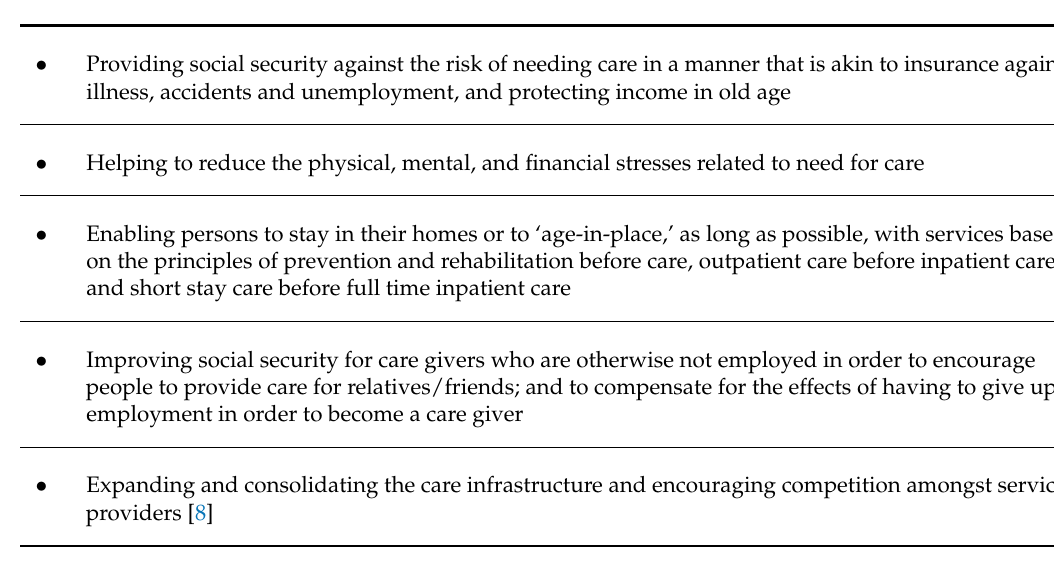
Table 1. German long-term care system, key